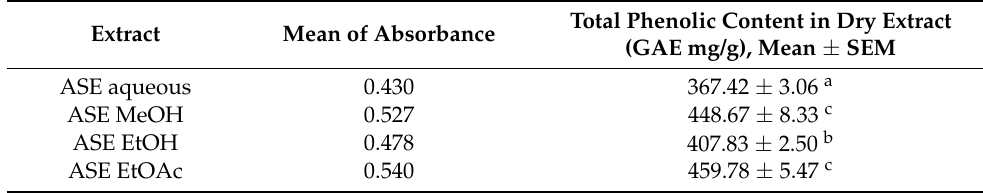
Table 3. Total phenolic contents (as GAE) in M. speciosa ASE leaf extracts obtained from various extraction solvents.